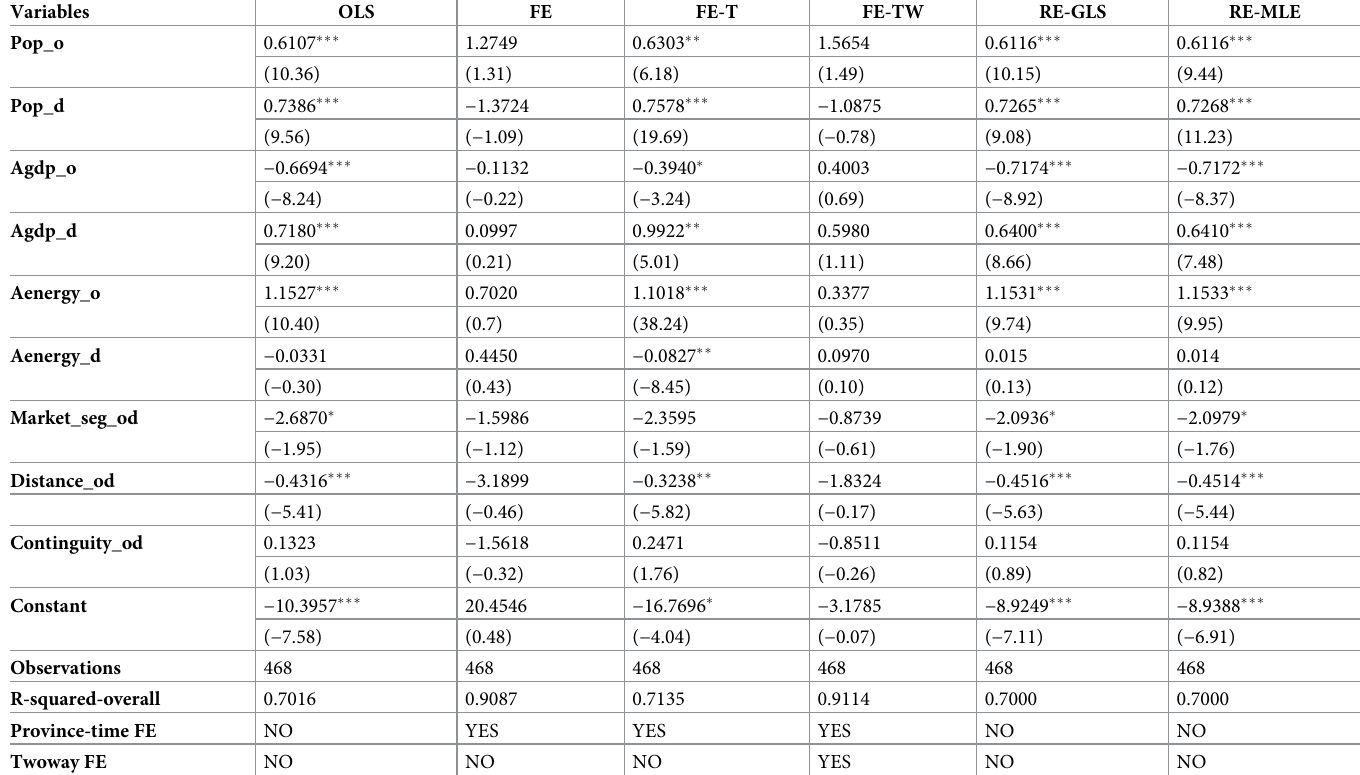
Table 5. The gravity estimated results using interprovincial embodied CO 2 flows between Eastern and Central China.